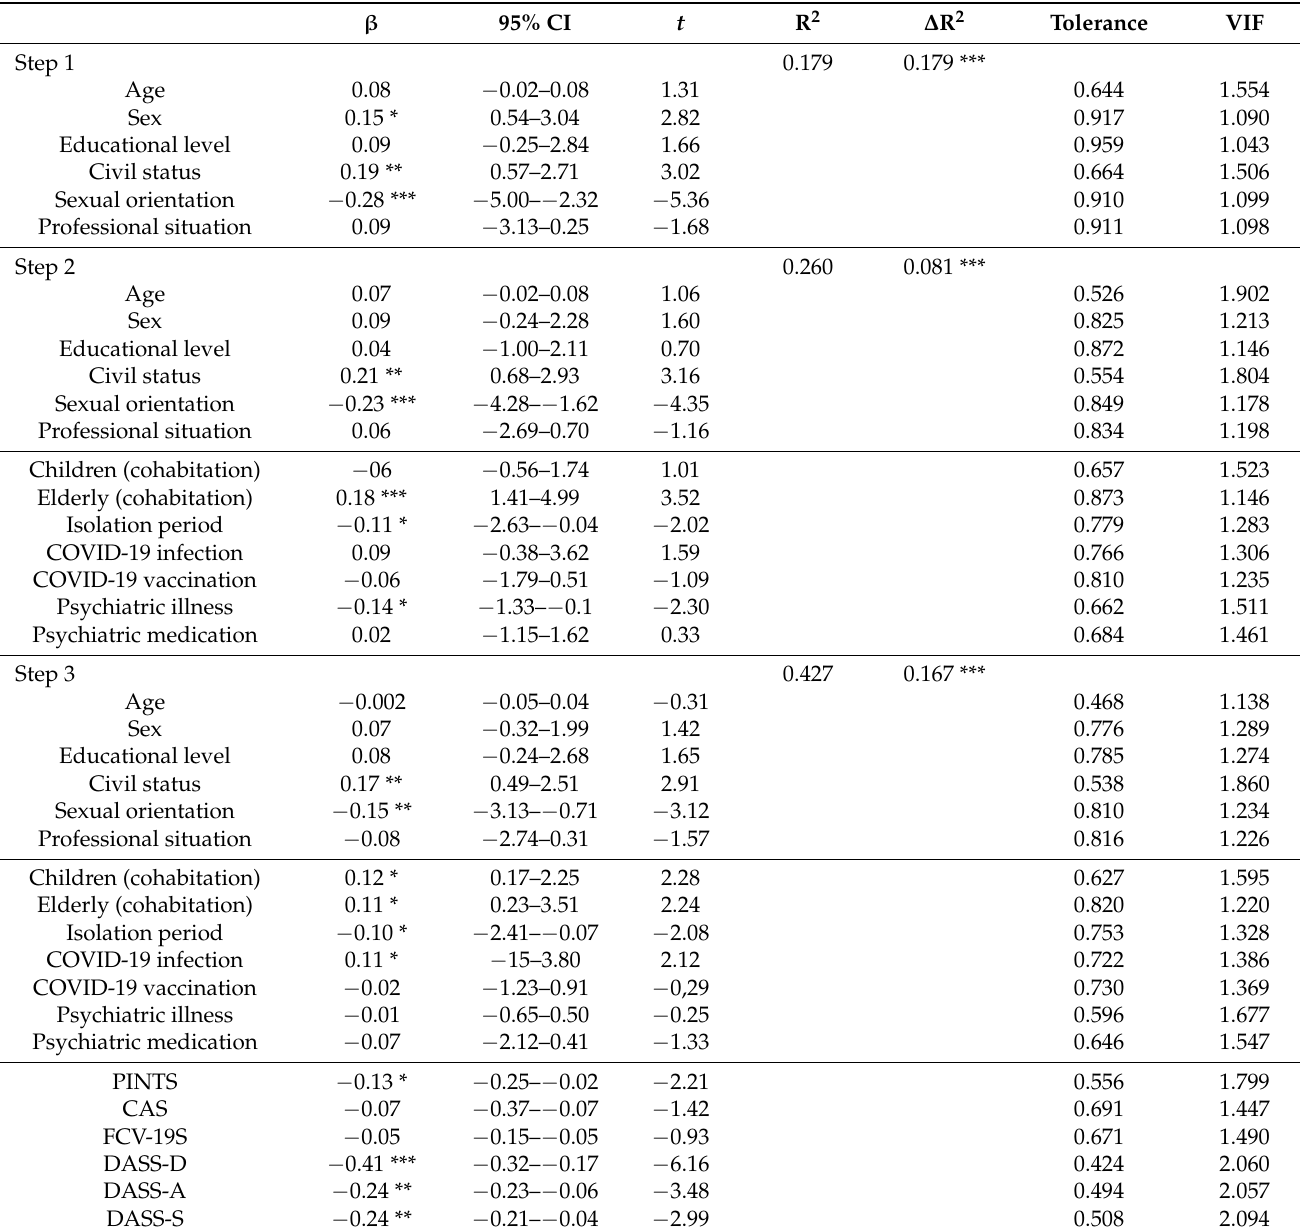
Table 3. Hierarchical regression analysis for cognitive subjective well-being with sociodemographic and psychopathological variables as predictors (N =